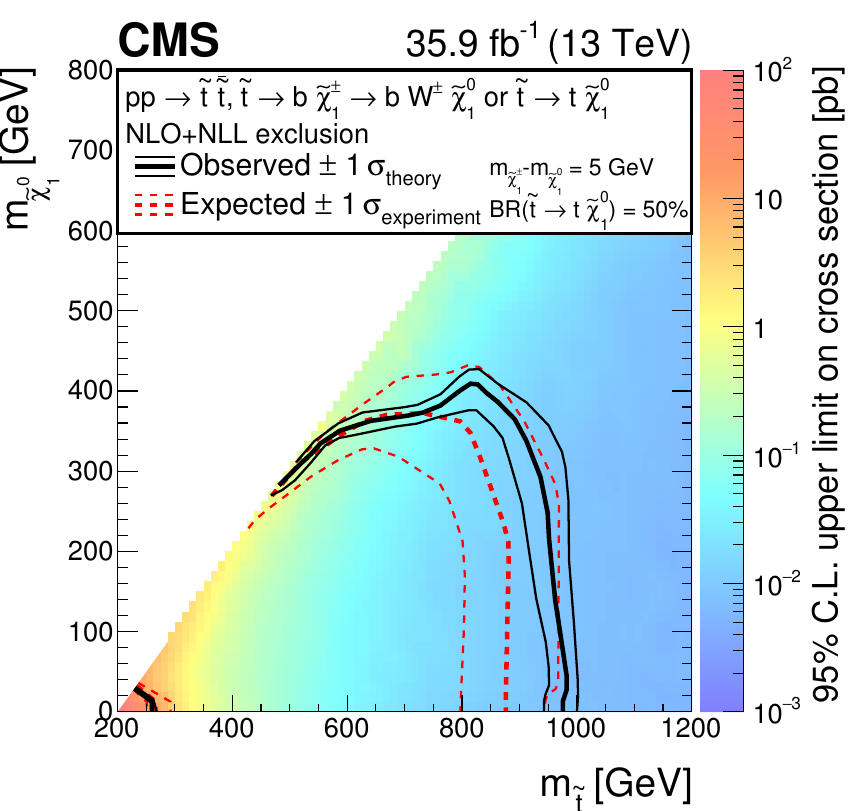
Figure 7 . The exclusion limit at 95% CL for direct top squark pair production with decay ! W b (cid:31) + t (cid:31) 0 , (cid:31) (cid:6) (cid:31) 0 . The mass splitting of the chargino and neutralino is (cid:12)xed to 5 GeV. The (cid:6) 1 1 1 1 interpretation is done in the two-dimensional space of m upper limit on the cross section at each point in the m e e e e black curves represents the observed exclusion region at 95% CL, while the dashed red lines indicate the expected limits at 95% CL and their (cid:6) 1 (cid:27) experimental standard deviation uncertainties. The thin black lines show the e(cid:11)ect of the theoretical uncertainties ( (cid:27) theory ) in the signal cross section.